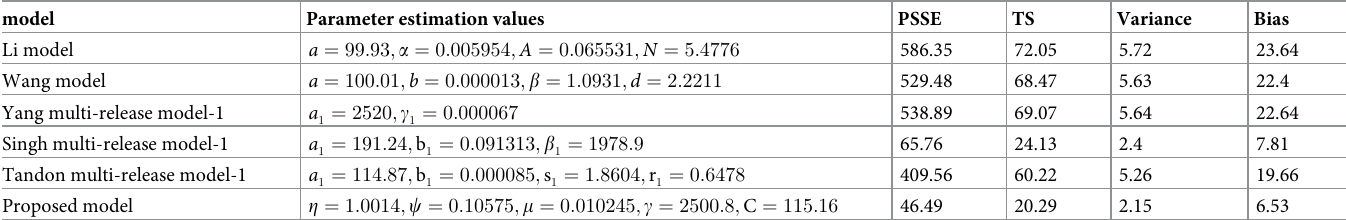
Table 5. Comparison of the predictive performance of models using 90% of fault data (DS2-1).